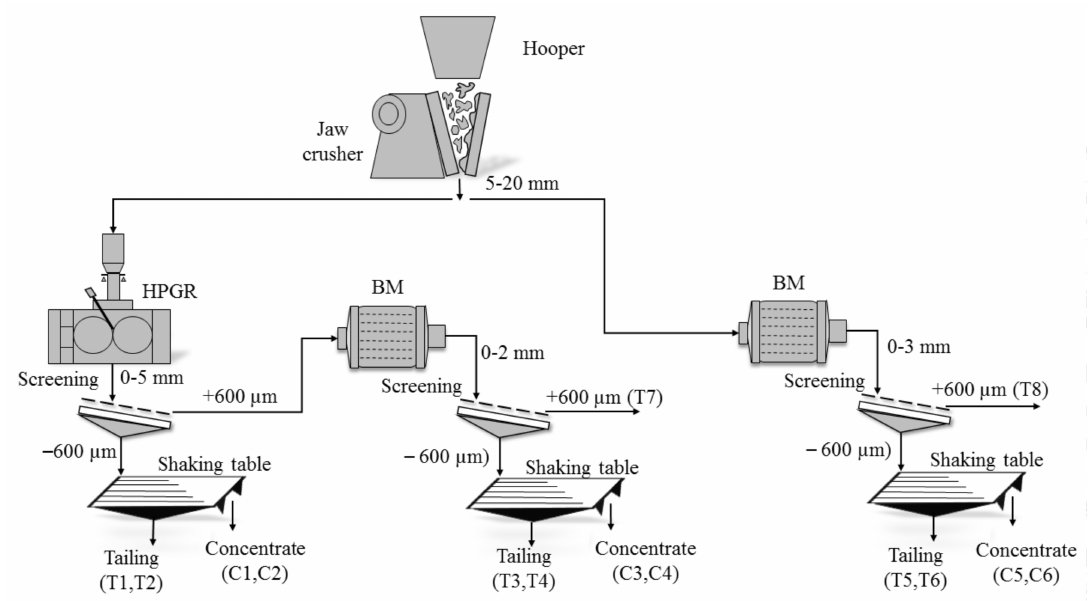
Figure 1. Schematic diagram of the Penouta open pit sample preparation. C, concentrate sample, T,